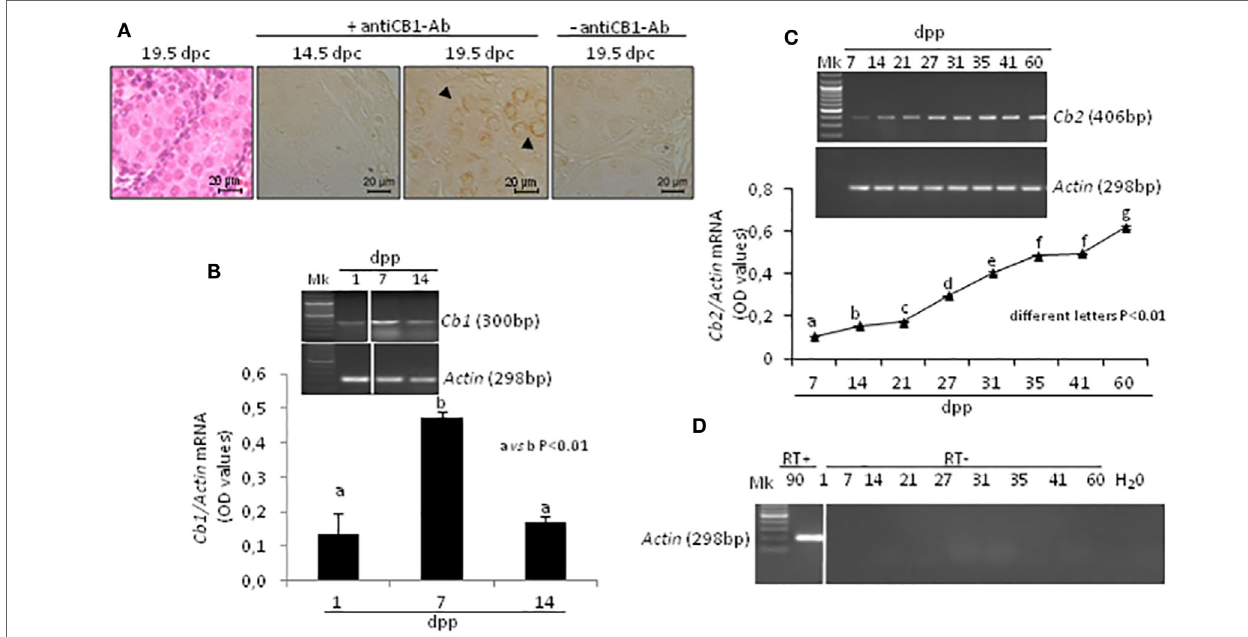
FigUre 2 | Expression of cannabinoid receptors in fetal and post-natal rat testis. Representative fetal testis section from 19.5 days post coitum (dpc) old rats stained with hematoxylin & eosin and immunostained for CB1. Arrowheads indicate immunopositive gonocytes. Scale bar: 20 µm (a) . Representative images of RT-PCR analyses showing Cb1 and Actin mRNA expression in rat testes from 1-to-14 days post partum ( dpp ). Cb1 expression was quantified by densitometry analysis, normalized against Actin signals and expressed in OD values (B) . Representative images of RT-PCR analyses showing Cb2 and Actin mRNA expression in rat testes, from 7 to 60 dpp . Cb2 expression was quantified by densitometry analysis, normalized against Actin signals and expressed in OD values (c) . Representative agarose gel image of RT + cDNA (testes from 90 dpp rats), RT − cDNA (testes from 1 to 60 dpp rats) and water (H 2 O) analyzed by PCR using actin primers (D) . All data are reported as the mean ± SEM. Different letters indicate statistically significant differences ( p < 0.01). The white bar in the agarose gel image indicates cropped figures from same